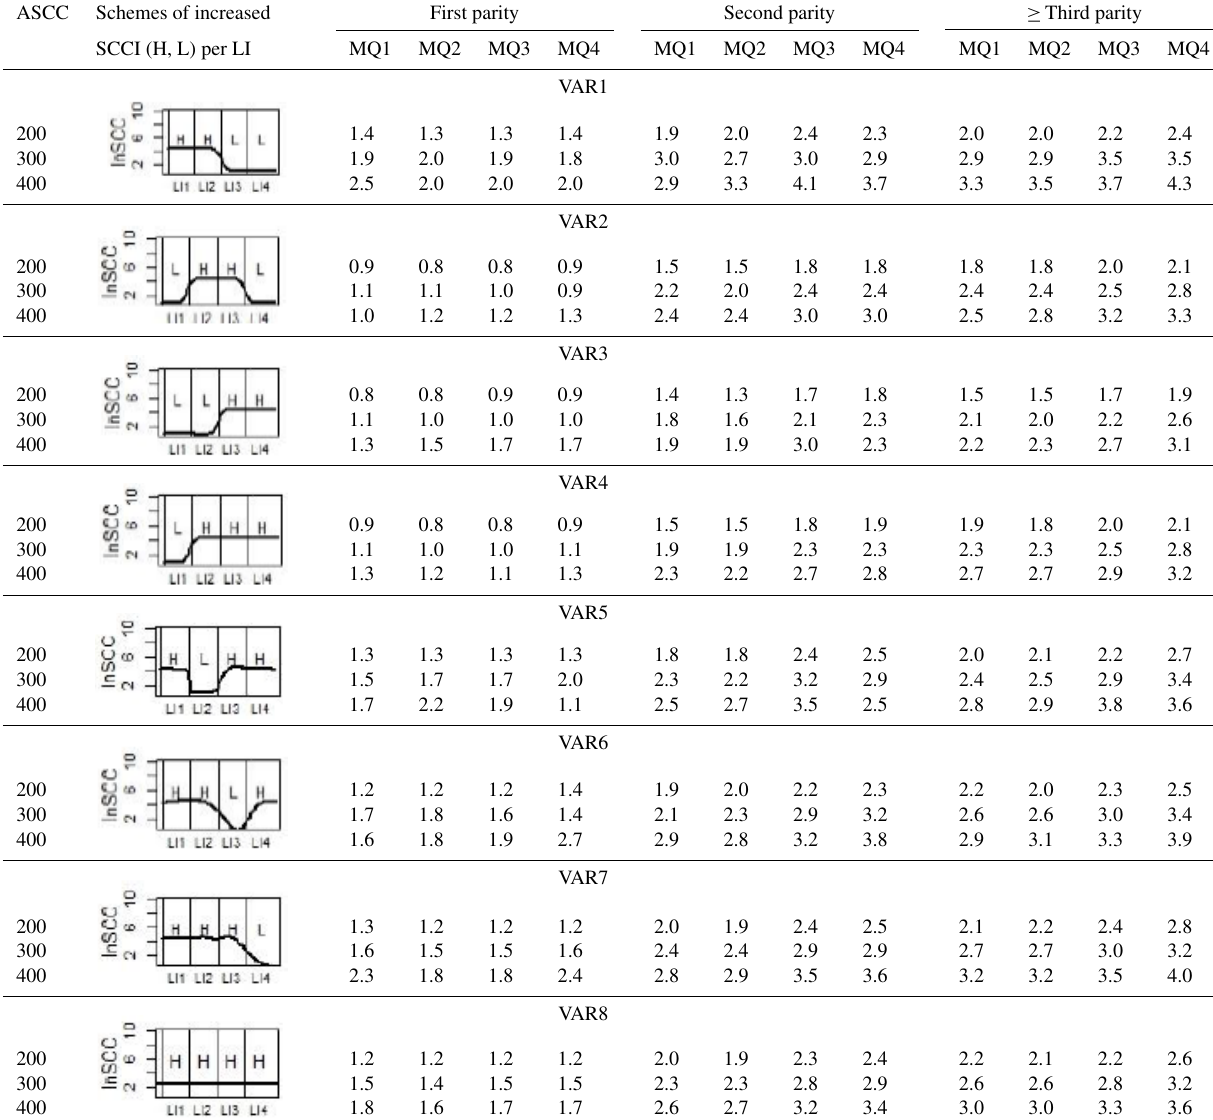
Table 5. Daily milk yield loss ( (cid:49) MY, kg) in various scenarios (VAR) of somatic cell index (SCCI) (H – high, L – low) according to lactation intervals (LI1 = 0–80, LI2 = 81–160, LI3 = 161–240, LI4 = 241–305 days in milk) within parity, milk production level (MQ), and level of average SCC ( × 10 3 )